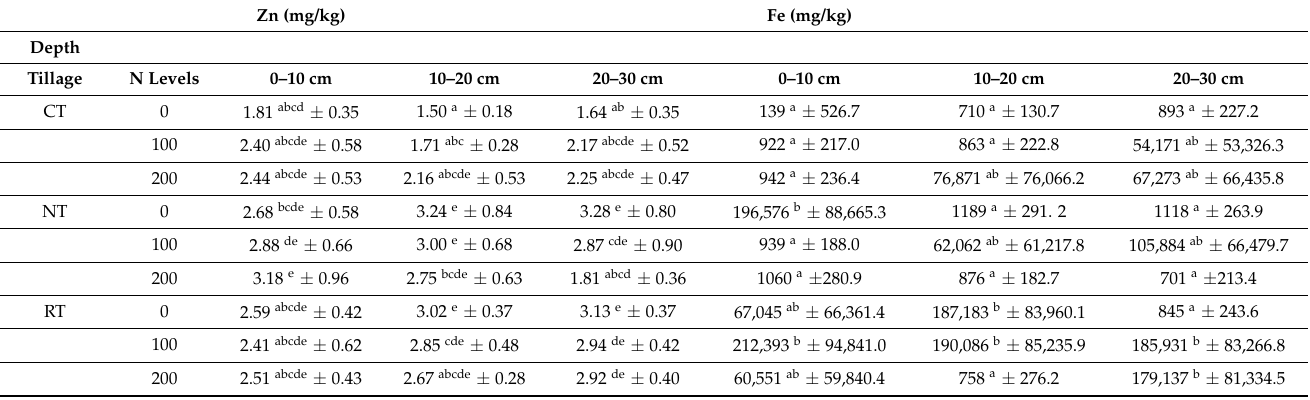
Table 5. Mean extractable zinc (Zn) and iron (Fe) (mg/kg) and standard errors of means found at different tillage treatments, sampling depths, and different N fertilizer application